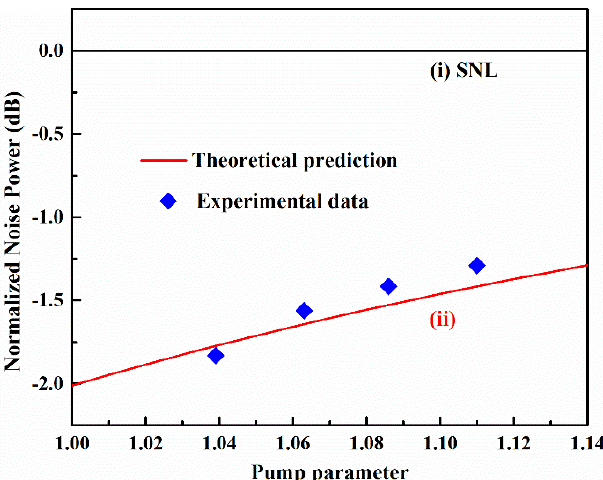
Figure 4. Normalized noise power spectrum of the intensity difference between two down-conversion beams. Curves (i): normalized SNL, curve (ii): theoretical prediction, blue diamonds: experimental data. The inserted figure is the normalized intensity noise power spectrum of the pump.